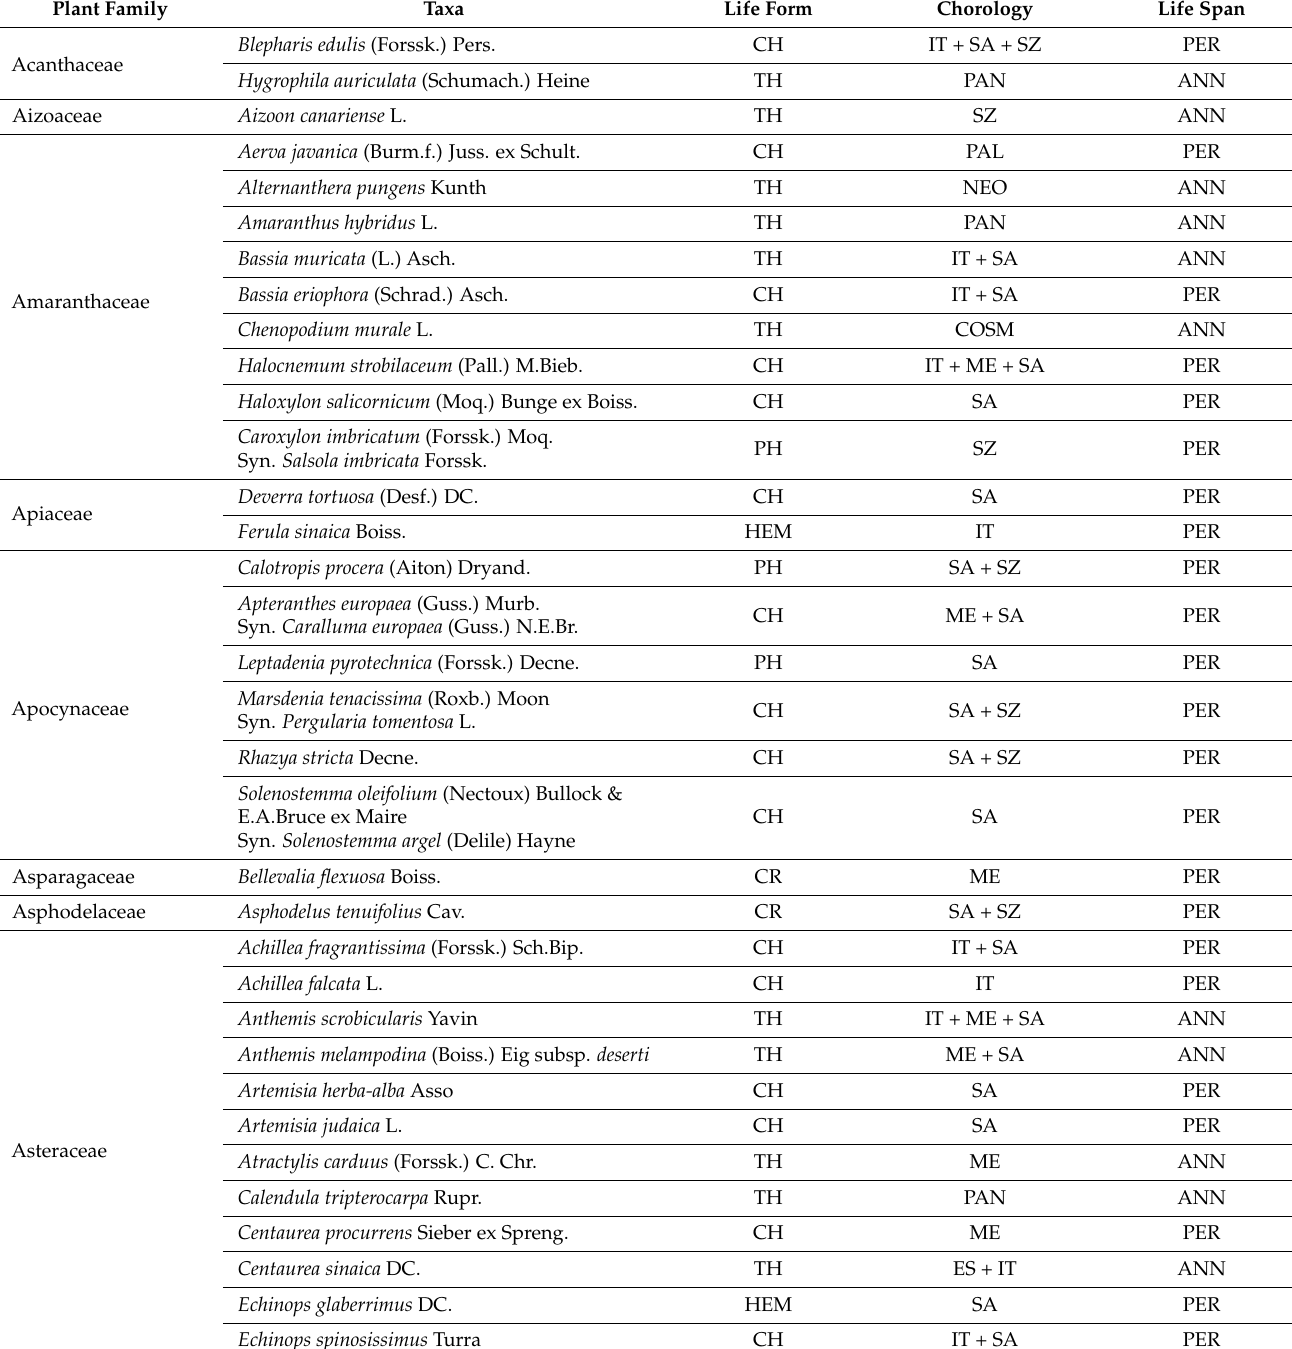
Table 2. List of plant taxa recorded in Jabal Al-Ward. Life span: Annual (ANN), Perennial (PER). Life form: Chamaephytes (CH), Cryptophytes (CR), Helophytes (HEL), Hemicryptophytes (HEM), Parasites (PA), Phanerophytes (PH), Therophytes (TH). Chorotypes: American (AM),